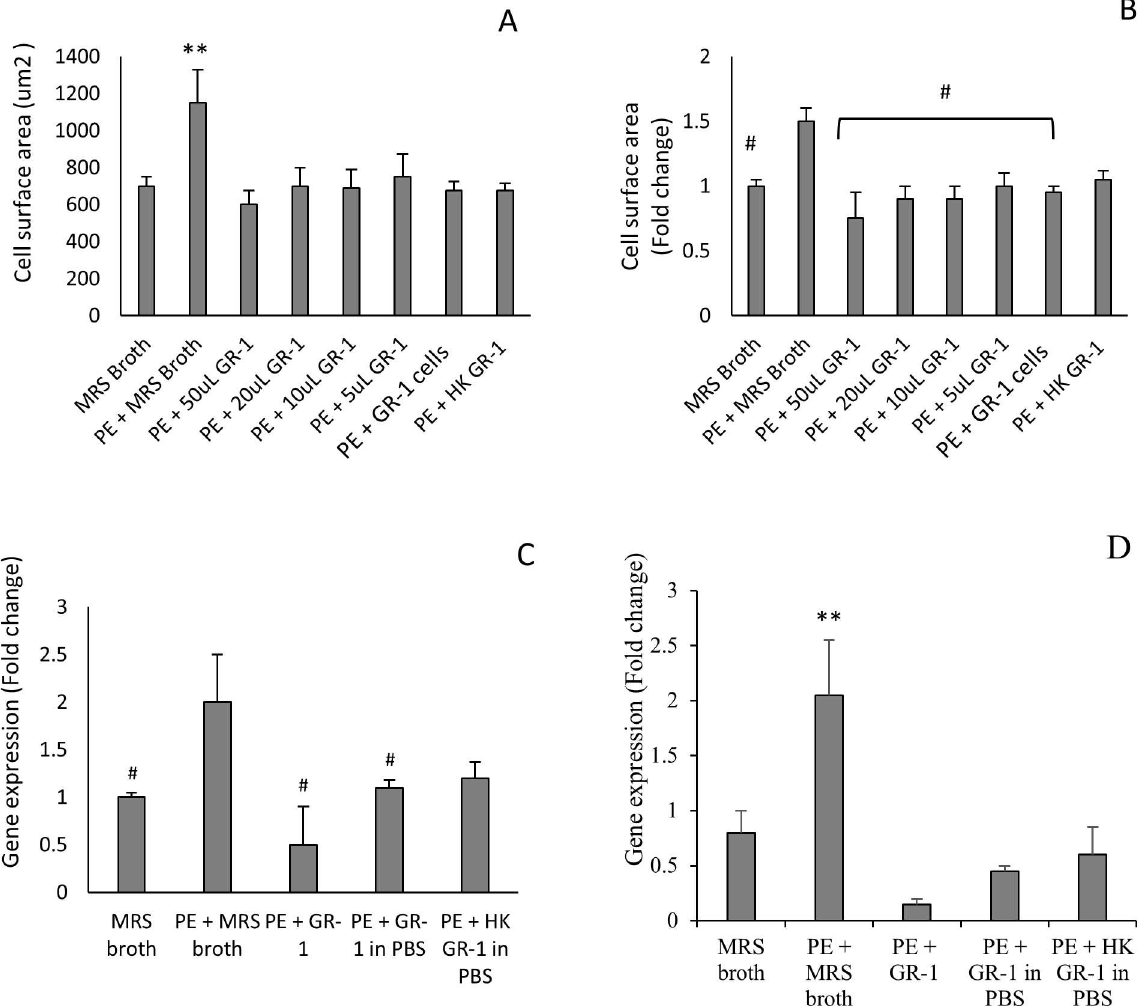
Fig 2. L . rhamnosus GR-1 inhibits PE-induced hypertrophy in NVCM. A : The NVCM surface area following24 hour co-culture with GR-1 (n = 5). PE + GR-1 = GR-1 bacteria in PBS; HK GR-1 = GR-1 bacteria heat killed. B : The fold change in NVCM surface area comparedto untreated(control) cells, following24 hour co-culture with GR-1 (n = 5). C, D : The fold changein gene expression of ANP (C) and aSKA (D) in NVCM (n = 3) respectively.Unless otherwisestated, all volumes of GR-1 treatments were 50 μ L (1 x 10 9 CFU/mL stock culture). * P < 0.05 and ** P < 0.01 comparedto all other treatments. * P < 0.05 comparedto PE + MRS broth. Error bars indicatethe standard